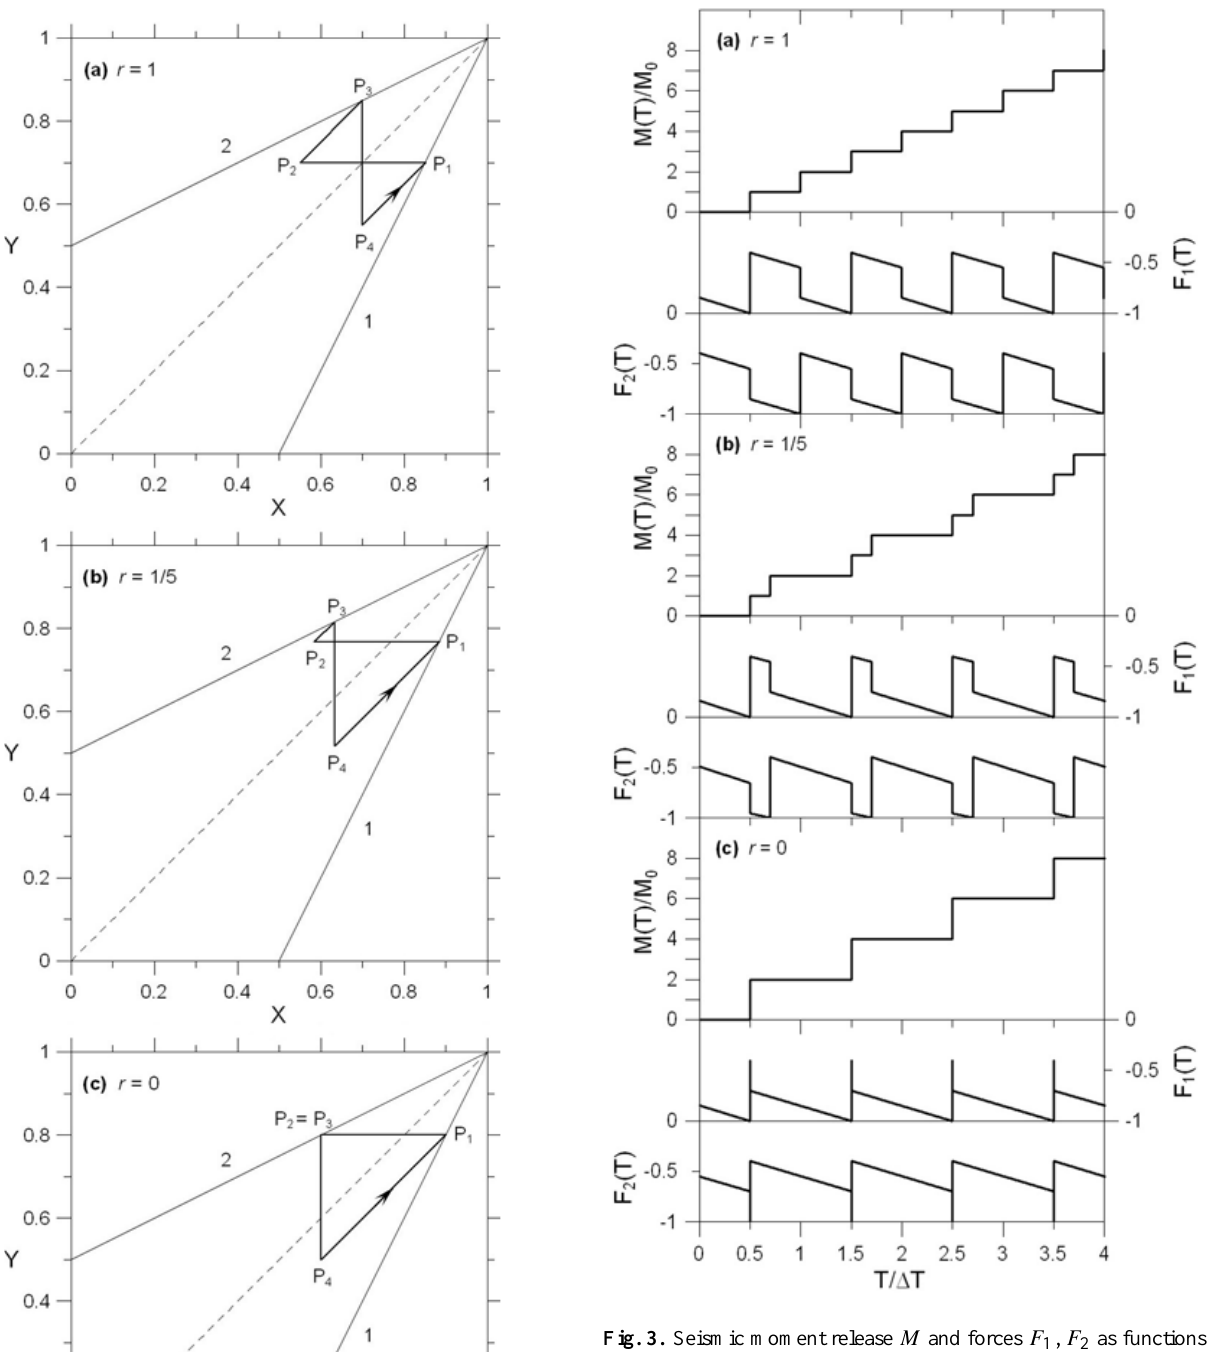
Fig. 3. Seismic moment release M and forces F 1 , F 2 as functions of time for the cycles shown in Fig.